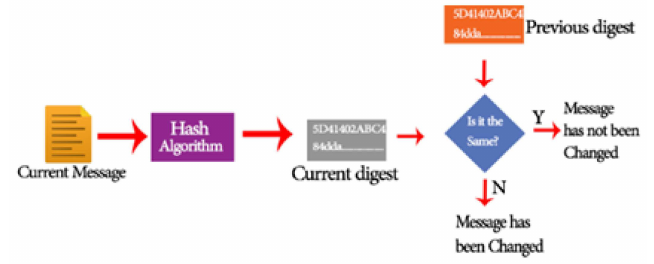
Figure 5. A schematic of file check